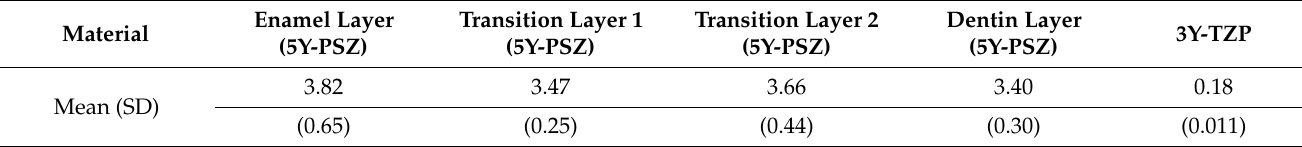
Table 3. Grain size of the four layers of 5Y-PSZ and of 3Y-TZP in µ m 2